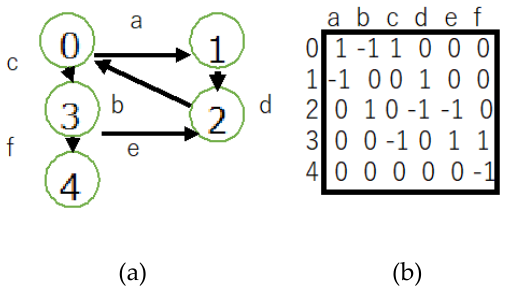
Figure 4. Example of matrix representation of decision tree. ( a ) Directed tree (decision tree). ( b ) Matrix representation of ( a ).